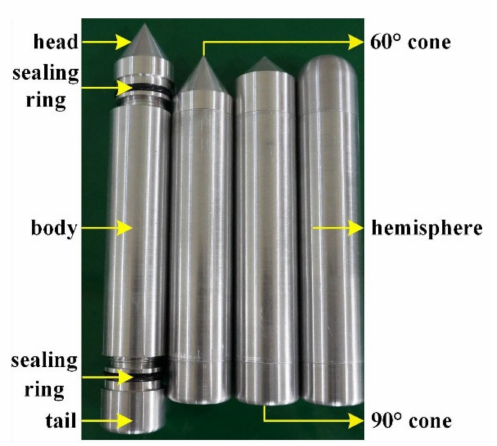
Figure 2. Experimental model design.